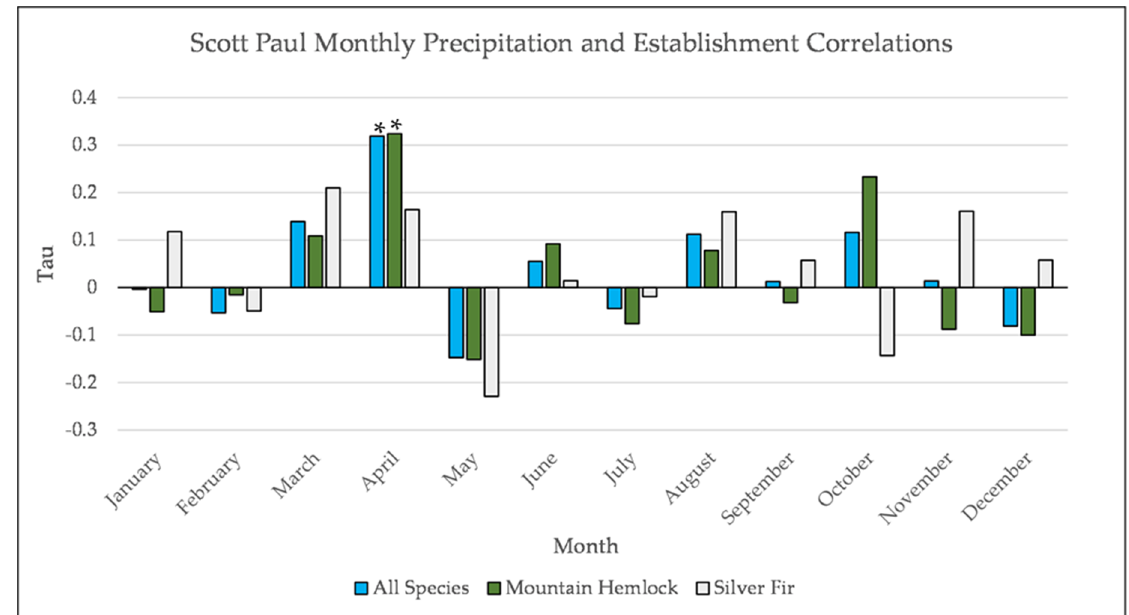
Figure A11. Partial Kendall’s correlation between mean monthly temperature and establishment at the Grouse Ridge site* = p -Value < 0.05, ** = p -Value < 0.01.